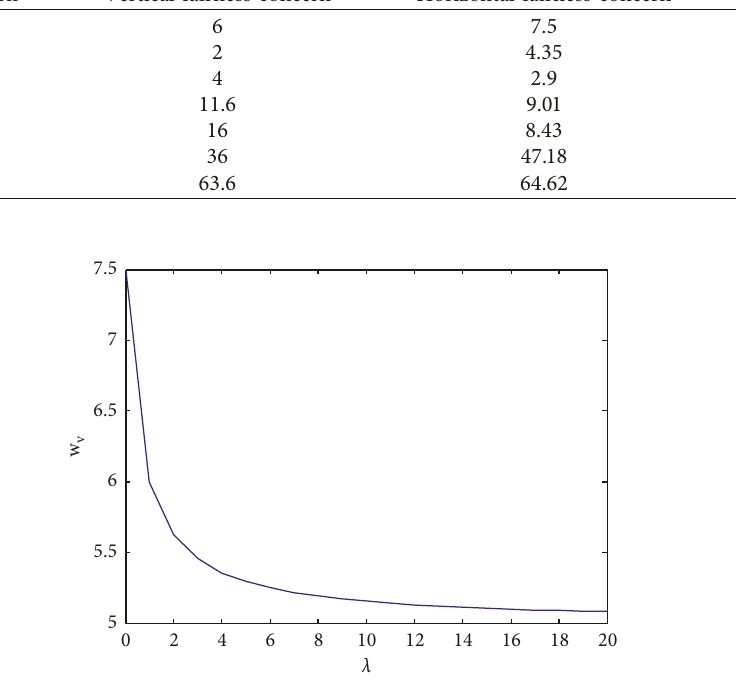
Figure 2: Impact of vertical fairness concern on the wholesale price.